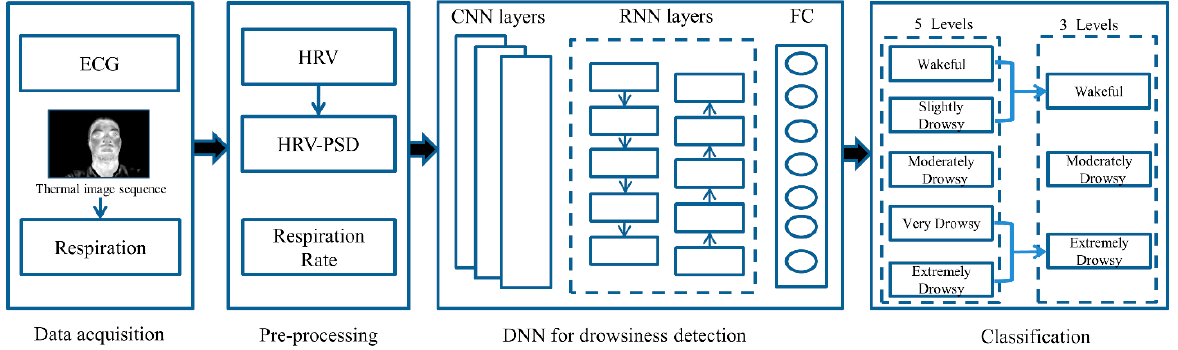
Figure 5. Overall flowchart of the proposed method for 3-level and 5-level classifications. ECG: electrocardiogram, CNN: convolutional neural network, RNN: recurrent neural networks, FC: fully connected.